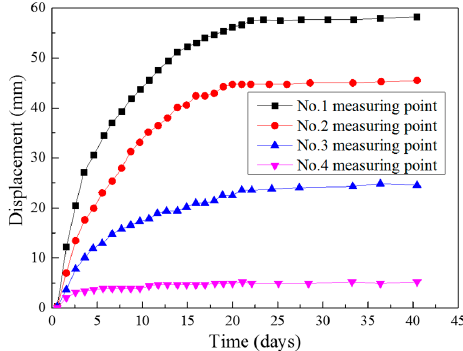
Figure 11. Time history plots of the internal displacements in class V rock masses at position C in the K89+729 section.